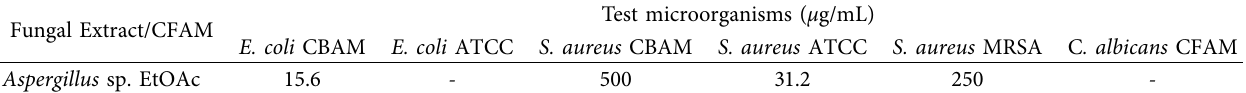
Table 2: Minimum inhibitory concentration of Aspergillus sp. extract against test microorganisms in μ g/mL. Fungal Extract/CFAM